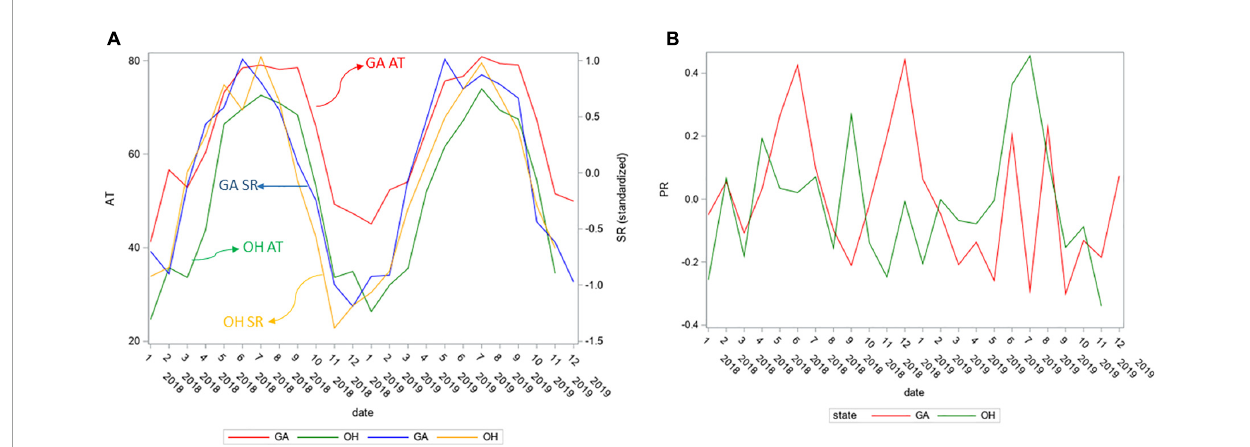
FIGURE8 (A) GA and OH monthly average air temperature (AT) and average solar radiation (SR) for study years 2018 and 2019. (B) GA and OH monthly average precipitation (PR) for study years 2018 and 2019. SR and PR were standardized to the same scale as they were measured differently in GA and